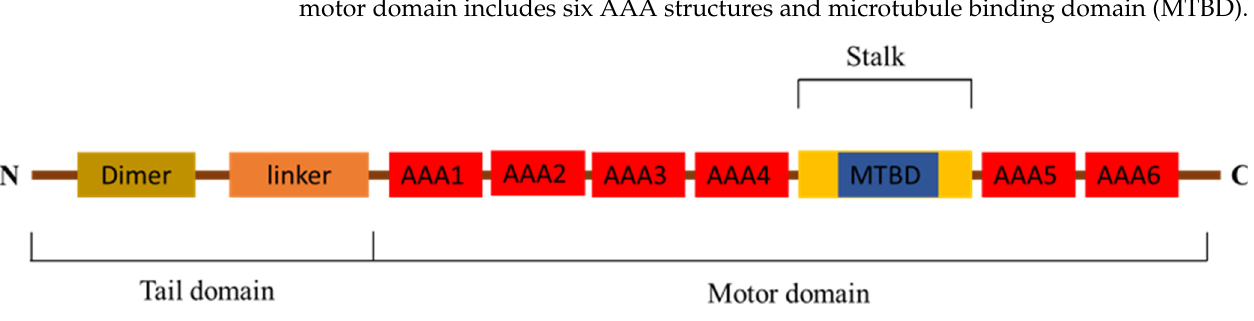
Figure 2. Phylogenetic tree based on DHC protein sequences. The phylogenetic tree was generated based on the alignment of proteins sequences using MEGA 5.0 software using neighbor-joining method. 3.3. The Expression of Pt-dhc in Different Tissues of P. trituberculatus We also analyzed the expression of Pt-dhc mRNA in heart (H), muscle (M), hepato- pancreas (Hep), gill (G), vas deferens (V) and testis (T) of P. trituberculatus . The qPCR